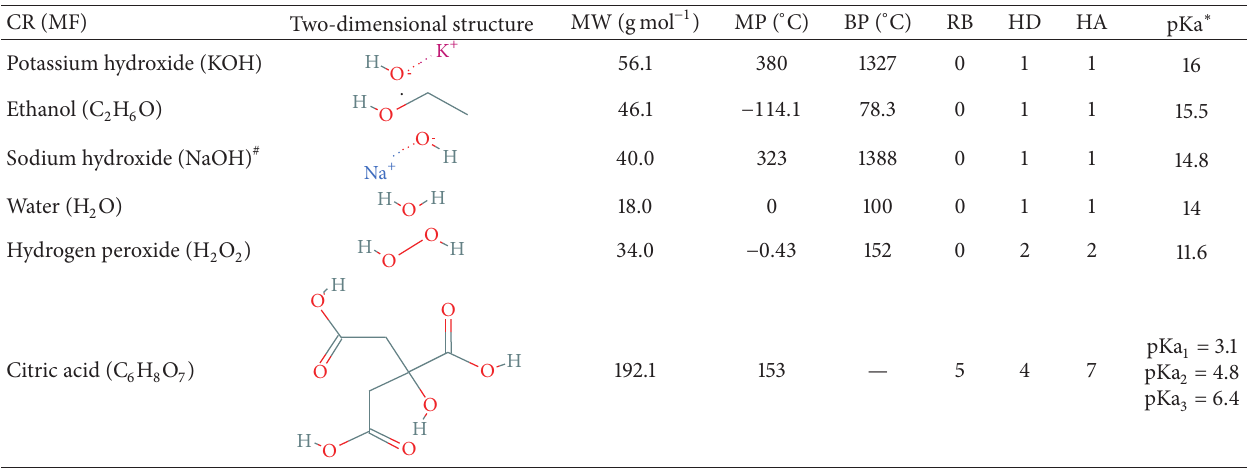
Table 1: Physicochemical properties of different chemical reactants in EHOs detergent formulations [22–24]. CR (MF) Two-dimensional structure K + Potassium hydroxide (KOH) H O